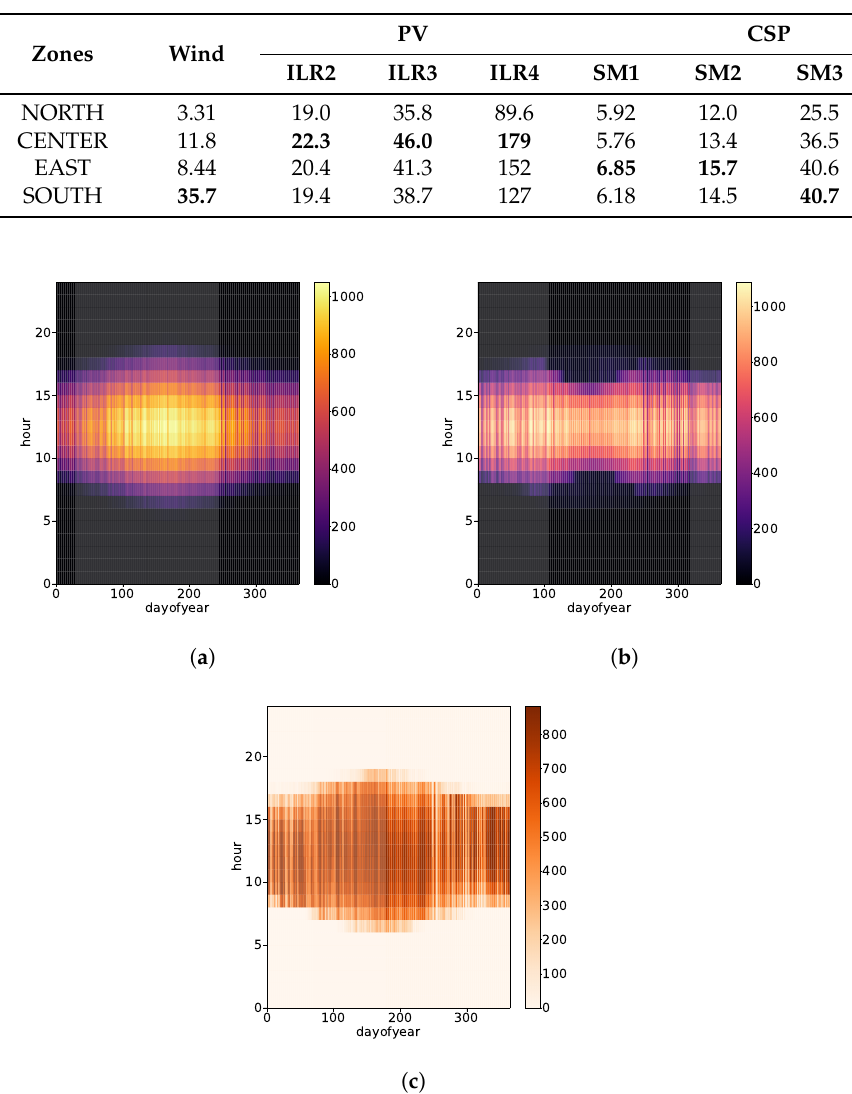
Figure 6. Heatmap of the national daily (ordinate) and seasonal (abscissa) variability of the solar radiation in (W/m 2 ): Global Horizontal Irradiation (GHI) ( a ), Global Tilted Irradiation (GTI) ( b ) (to be compared with Figure 7a–d, Direct Normal Irradiation (DNI) ( c ) (to be compared with Figure 8). The variation over time is shown in colour by intensity in the colour